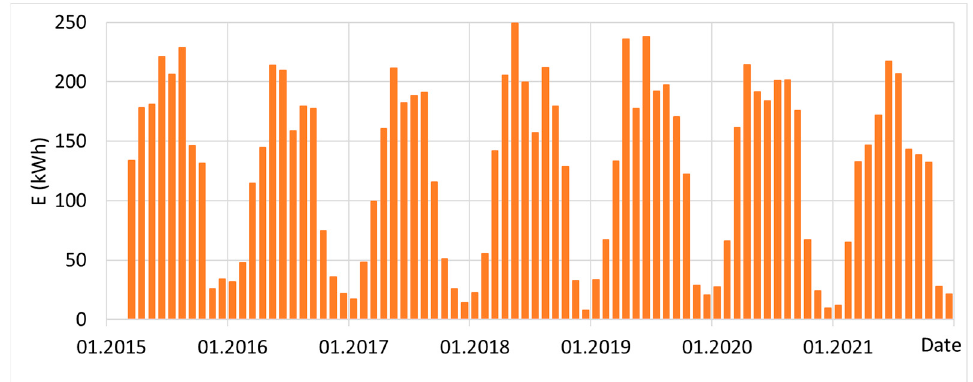
Figure 13. Monthly values of generated energy in PV1 section (own measurement data).